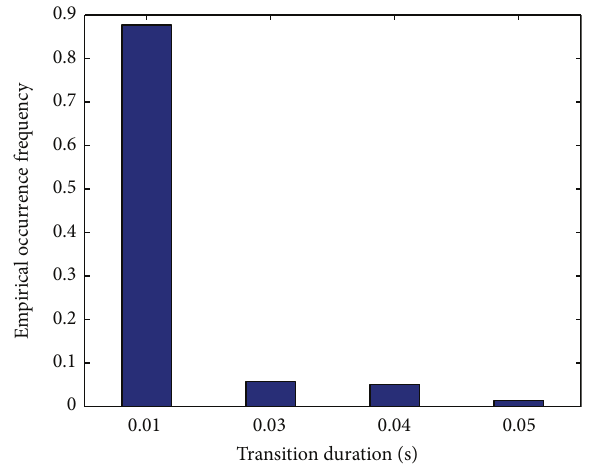
Figure 17: The empirical occurrence frequency of transition dura- tion from LoS points to NLoS points or NLoS points to LoS